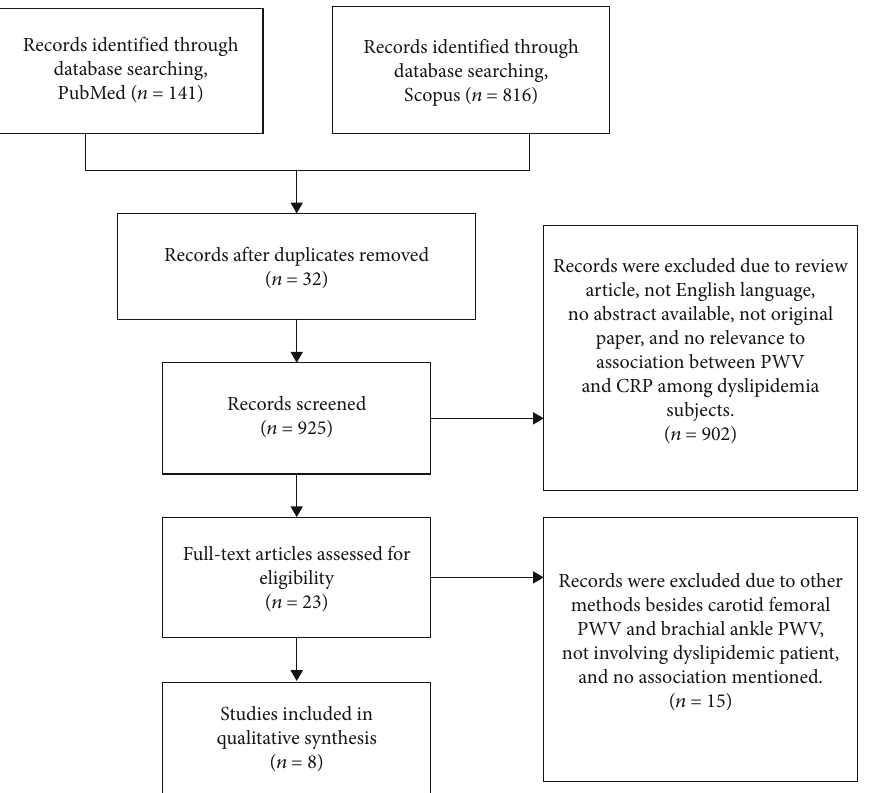
Figure 1: Flowchart of selection of the related